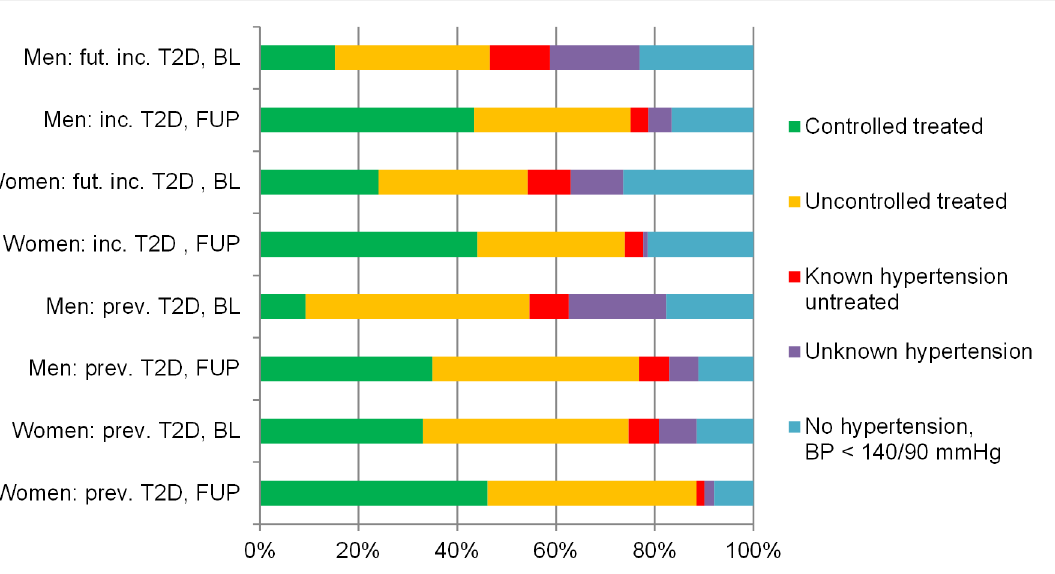
Fig 1. Sex-stratified frequencies of controlled treated, uncontrolled, known but untreated and unknown hypertension in participants with prevalent and (future) incident T2D in the baseline and follow-up examinations. Hypertension was defined as blood pressure (cid:1) 140/90 mmHg. Numbers are weighted and given as % .